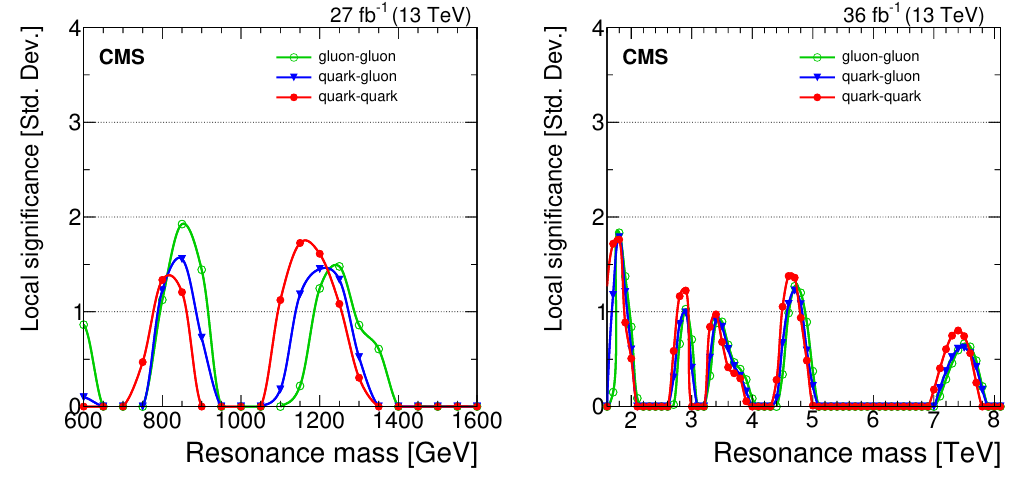
Figure 9 . Local signi(cid:12)cance for a narrow resonance from the low-mass search (left) and the high- mass search